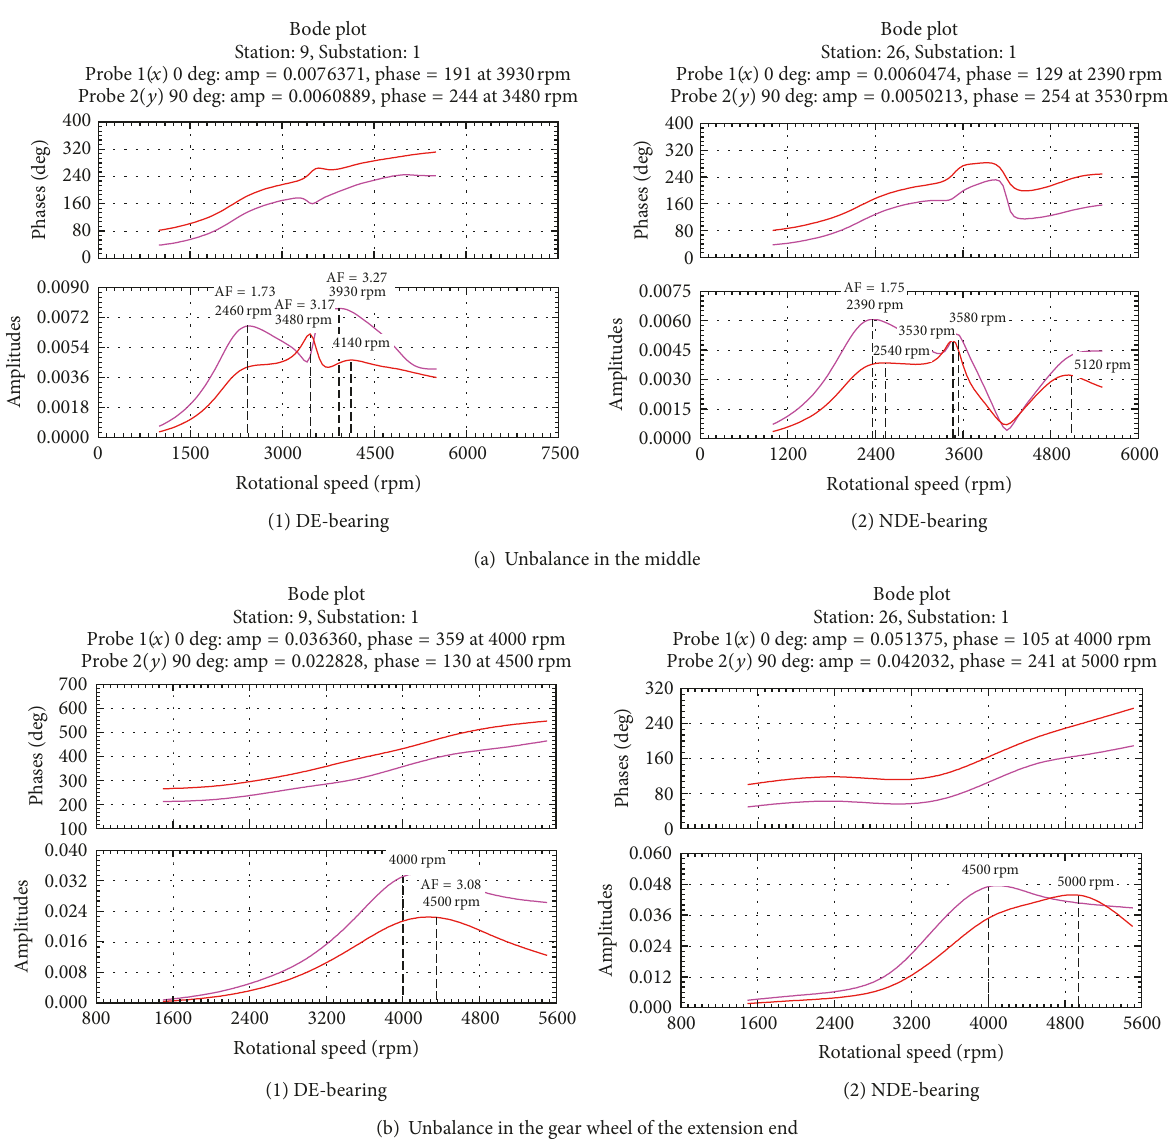
Figure 5: The bode chart of unbalanced response of cylindrical